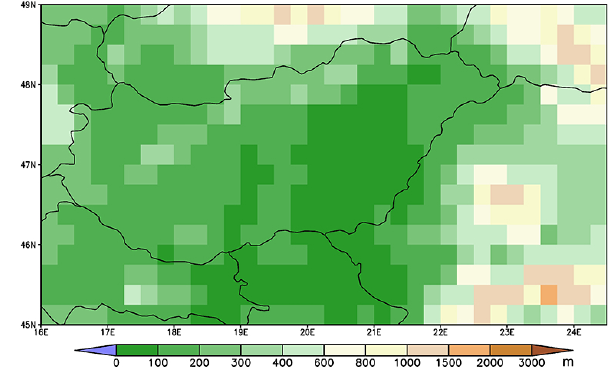
Fig. 1. Topography and grid cell representation of the selected do- main covering